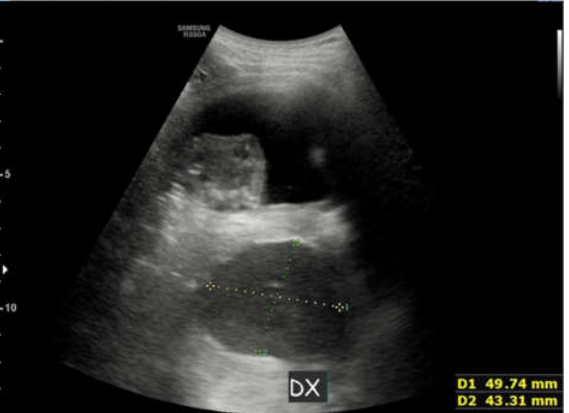
Figure 3. Image of the ultrasound performed on admission to the hospital ward. A pleural effusion and an oval formation of 49 × 43 mm is seen.